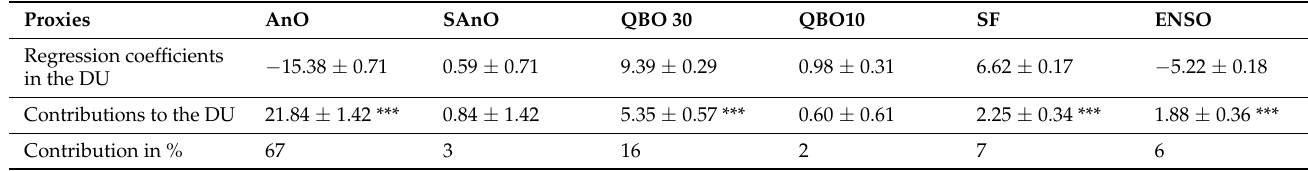
Table 3. Regression coefficients and contributions of the